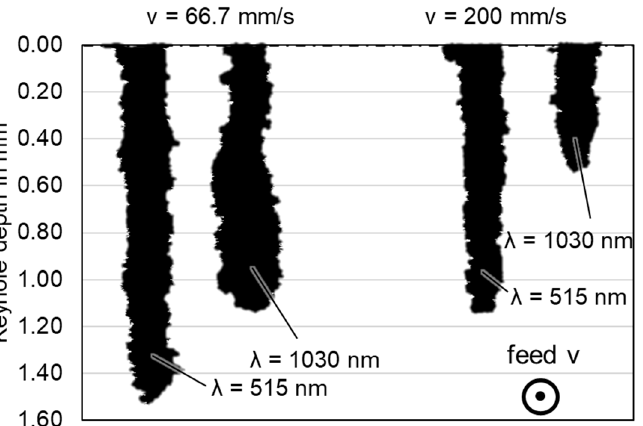
Figure 12. Keyhole shapes in width direction (view against feed direction) for laser beam welding of copper using 515 nm and 1030 nm wavelengths for feed rates of v = 66.7 mm/s ( left ) and v = 200 mm/s ( right ), P L = 3 kW.